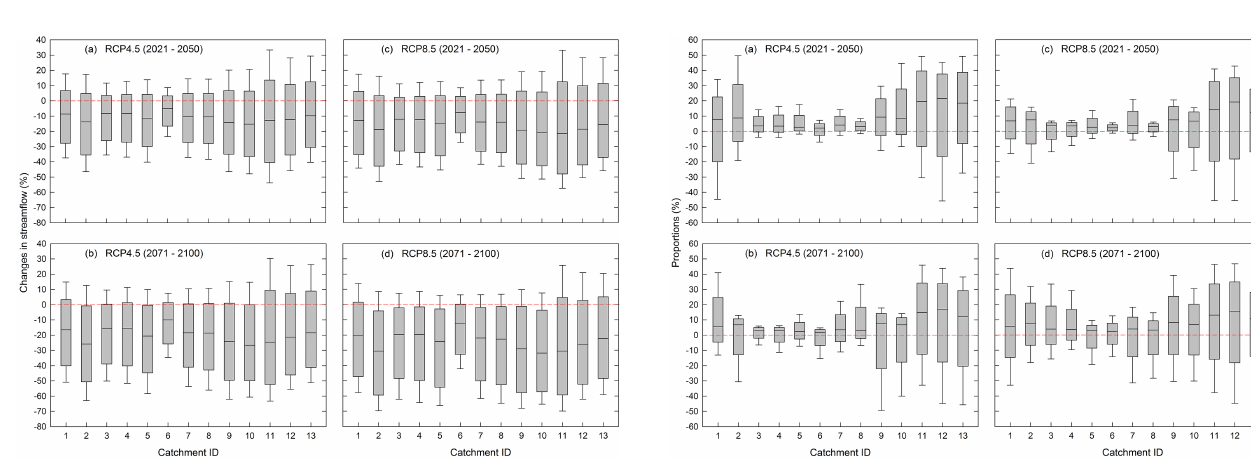
Figure 8. Box plots of the net climate change (CC + LAI) effect on mean annual runoff during 2021–2050 and 2071–2100 under RCP4.5 (a, b) and RCP8.5 (c, d) emission scenarios from each of the 38 CMIP5 runs. Changes are relative to the historical (1981– 2010) period. The lower boundary of the box indicates the 25th per- centile, a line within the box marks the median, the upper boundary of the box indicates the 75th percentile and the whiskers are delim- ited by the maximum and minimum.